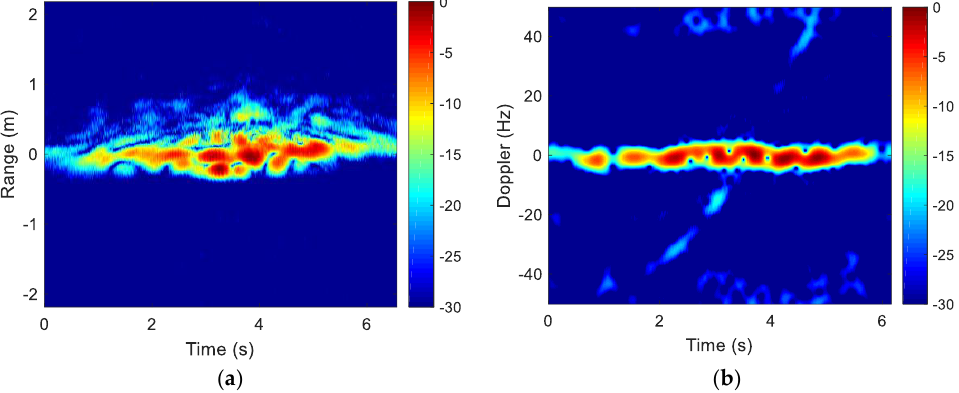
Figure 10. Drone motion compensated data. ( a ) Aligned range profiles; ( b ) Aligned Doppler profiles.